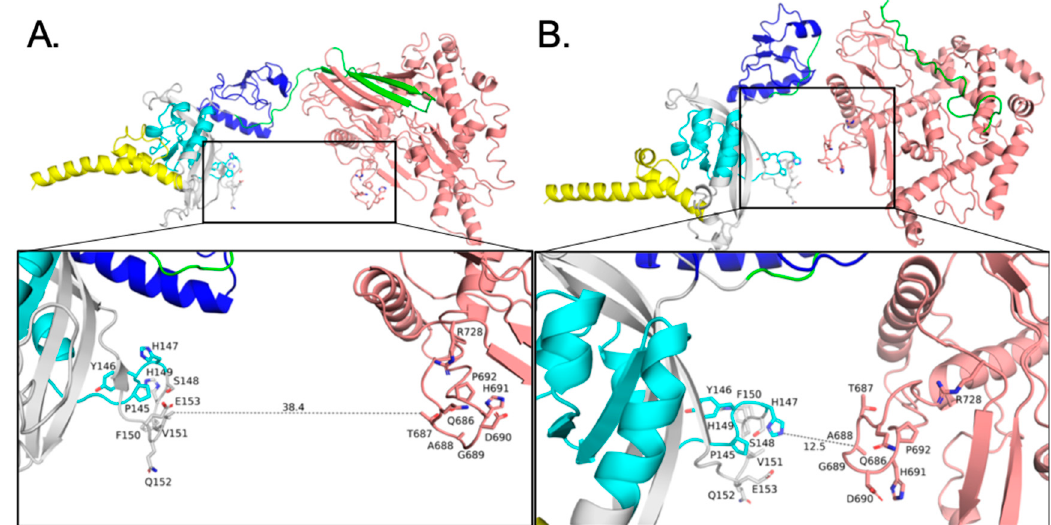
Figure 5. Closure of space between PASA domain and SM domain in WT SIM1 during apo simulation. The structure is colored by domain (as per Figure 1A) and rendered in ribbons and licorice sticks for residues of interest. ( A ) SIM1 in its apo, unbound form is shown for the initial starting conformation. Call-out box shows a close-up of the PASA domain and SM domain, with a 38.4 Å gap where ARNT would occupy. ( B ) SIM1 in its apo, unbound form is shown after completion of >100 ns simulation. Call-out box shows a close-up of the same region, now approximately 26 Å closer. This closed conformation would preclude ARNT from binding.